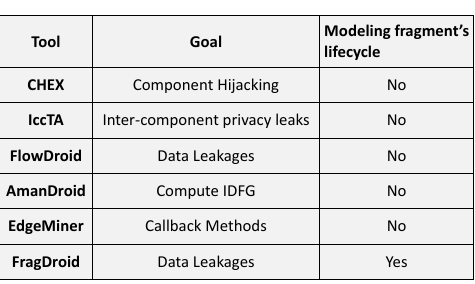
Figure 14. Comparison of different taint analysis